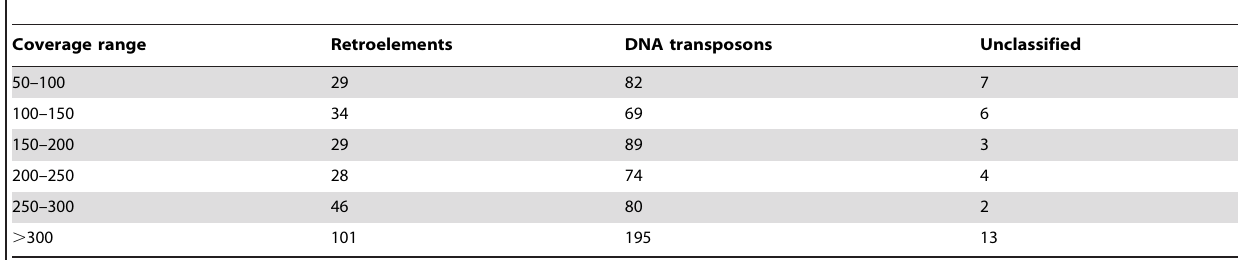
Table 2. Summary of repetitive element analysis in the SNP flanking regions, including retroelements, DNA transposons and unclassified repetitive